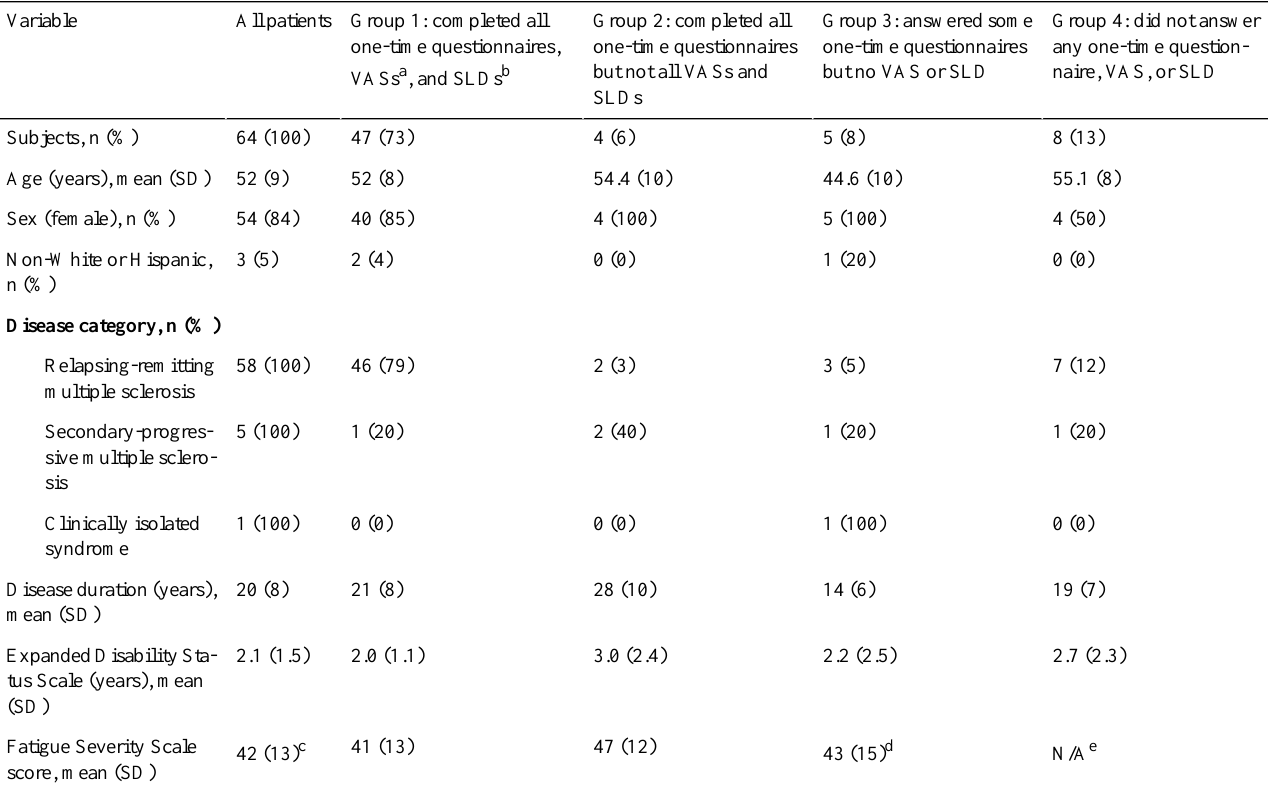
Table 1. Characteristics and compliance of the study participants.